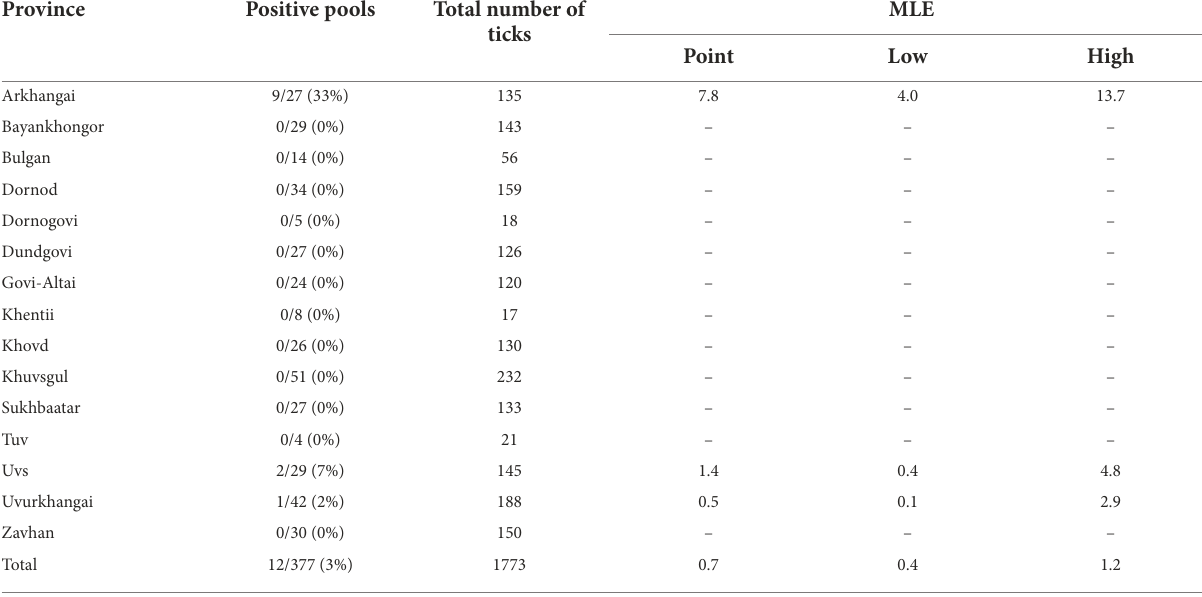
TABLE 4 Maximum likelihood estimates of Anaplasma spp. by region based on confirmatory results including 95% confidence intervals. Anaplasma spp.